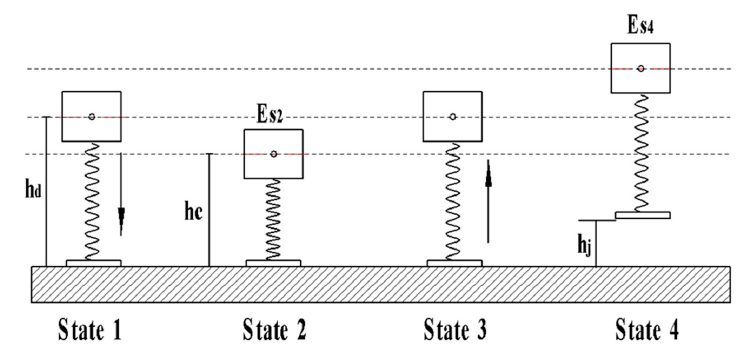
Figure 5. A simplified model of the jumping process.